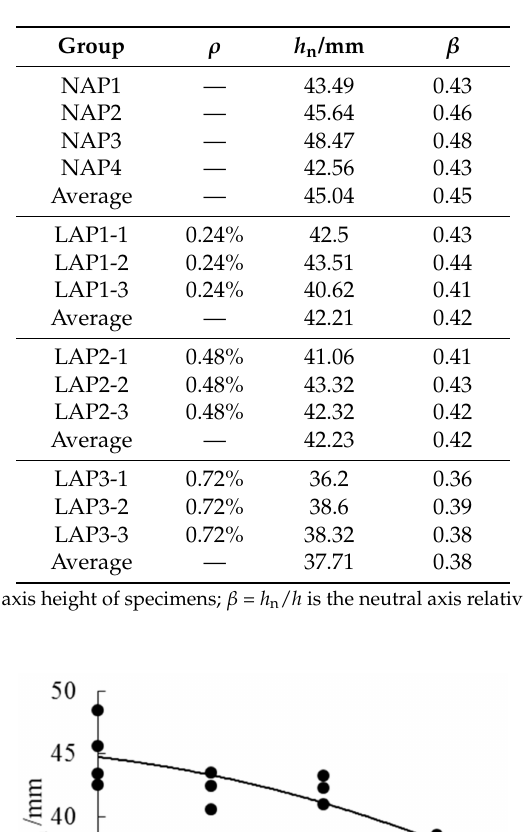
Table 4. The neutral axis position for the ultimate load.